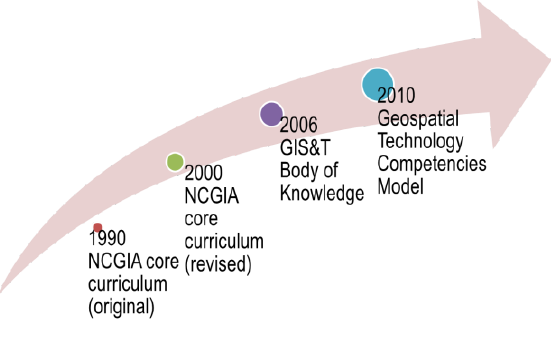
Figure 2: Development of GIScience